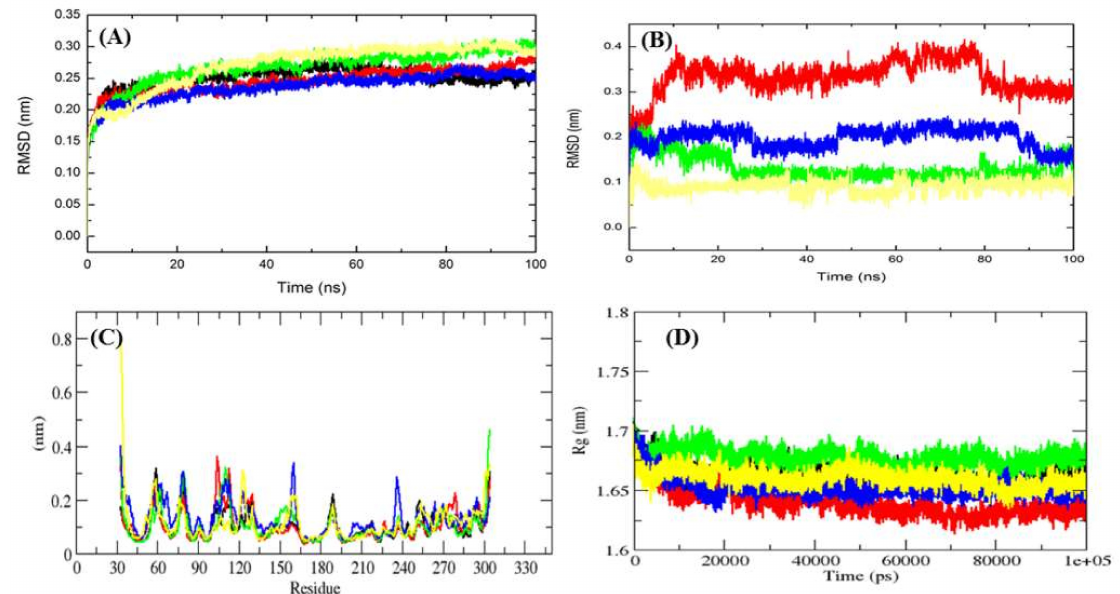
Figure 4. Dynamics of ligands binding to the Mrlip1. ( A ) RMSD plot for Mrlip1 as a function of time. ( B ) RMSD plot for ligands as a function of time. ( C ) Backbone residual fluctuations (RMSF) plot. ( D ) Time evolution of radius of gyration ( R g ). The values were presented during 100,000 ps (100 ns) MD simulations time scale. Black, red, green, blue, and yellow colors represent values obtained for Mrlip1, Mrlip1-RHC80267, Mrlip1-ZINC85530919, Mrlip1-ZINC95914464, and Mrlip1-ZINC85530320 complexes